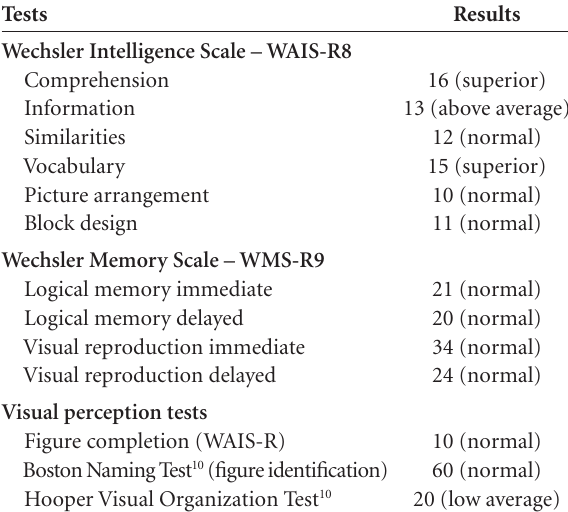
Table 1. Measures of global cognition and visual perception tests.